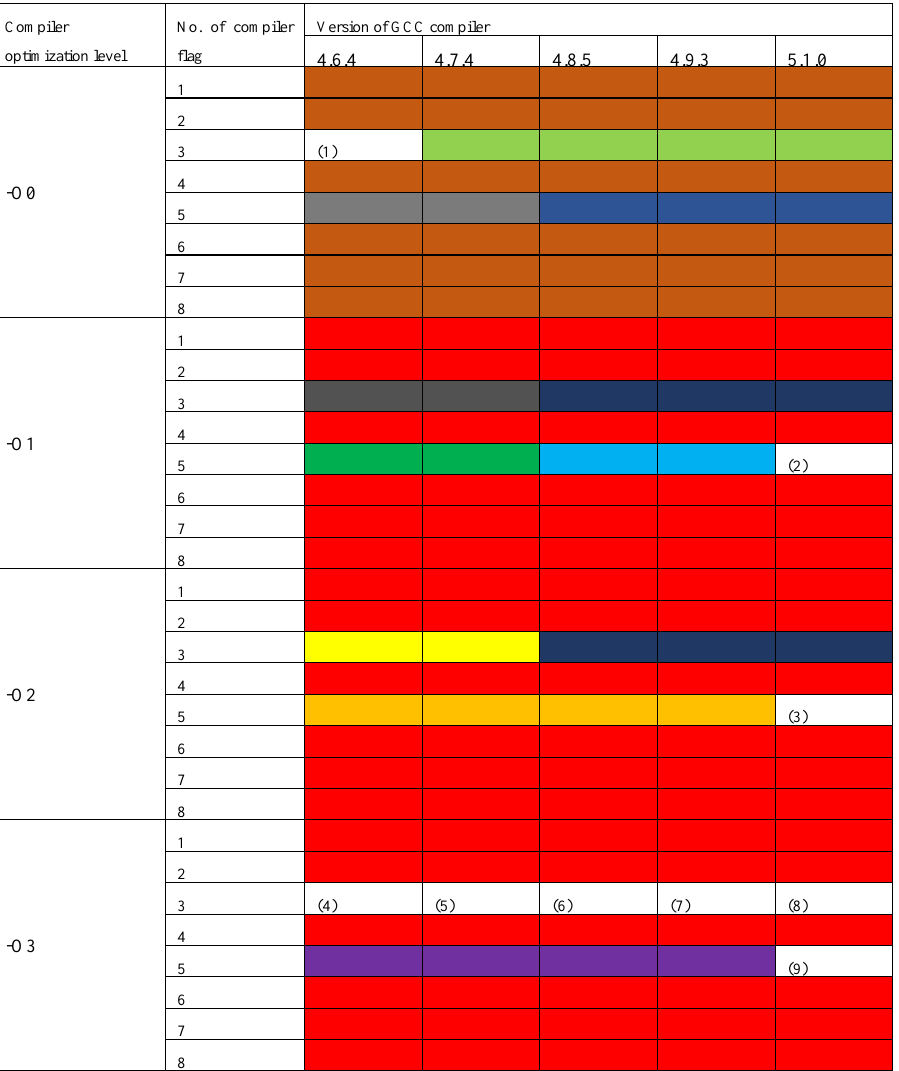
Table 12. Similar to Table 11 except for the simulation results of POP2. Table 12: Similar to Table 11 except for the simulation results of POP2.